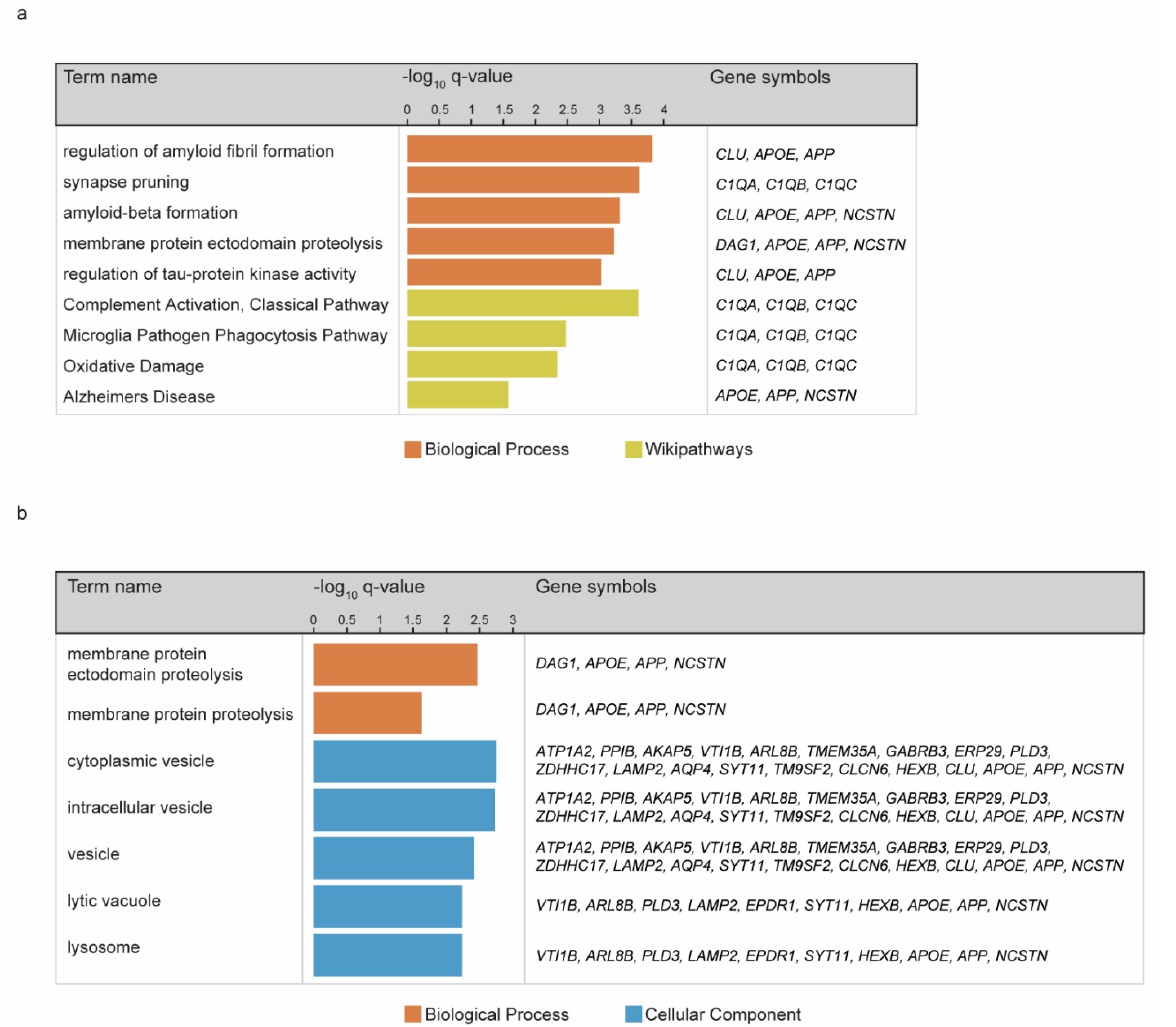
Figure 4. GO enrichment analysis on upregulated proteins in the 12-moa APP/PS1 dataset. ( a ) Enrichment analysis using the whole mouse genome as background results in terms related to A β and AD. ( b ) The use of the total list of proteins detected at 12-moa as background results in enrichment terms related to proteolysis and lysosome.